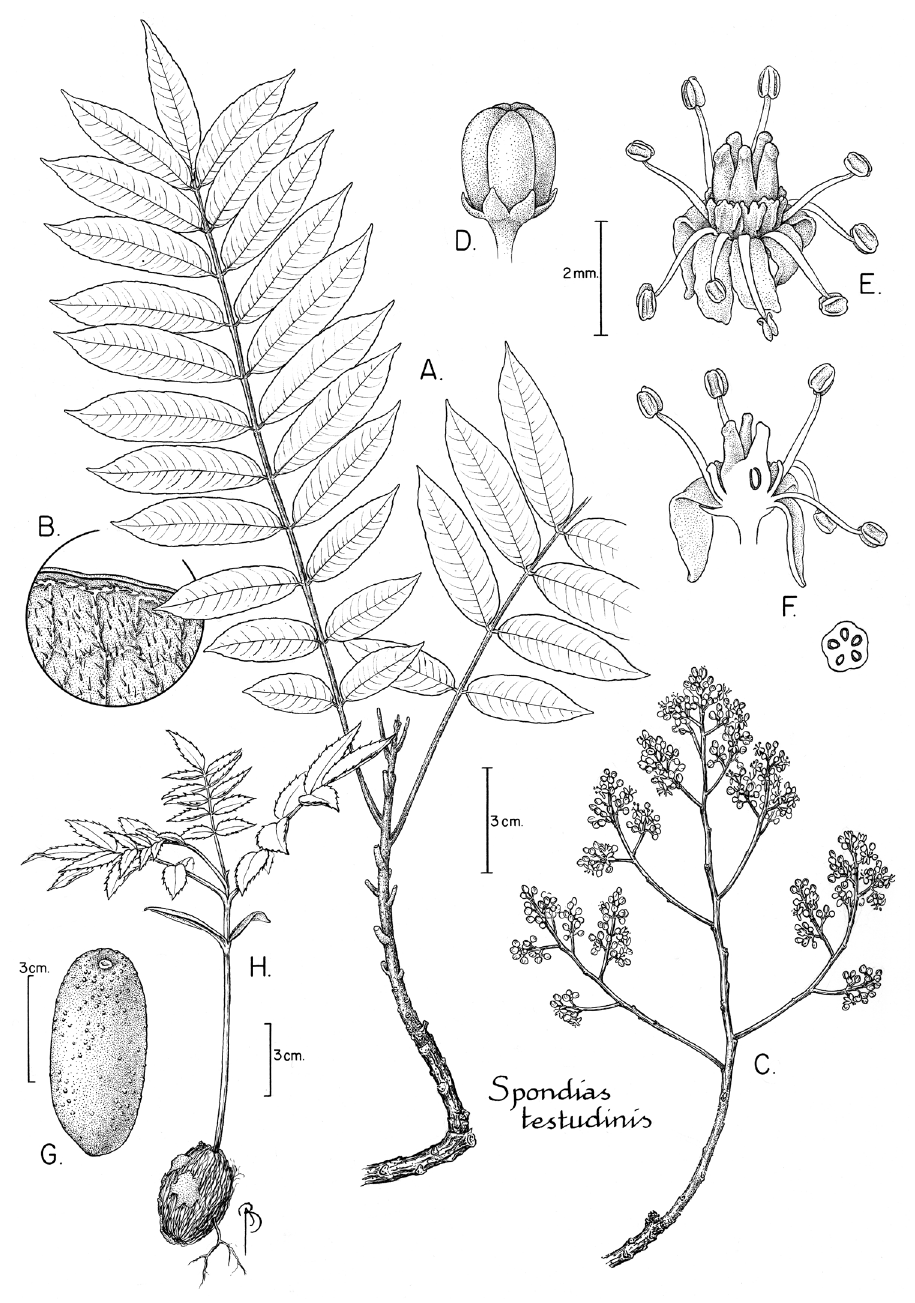
Figure 17. Spondias testudinis . A Branchlet B Detail of leaflet blade and margin C Inflorescence D Bud E Flower at anthesis F Longisection through same at center G Fresh fruit H Seedling. A, B from Lao Magín 112 (NY) C–F from Lao Magín 83 (NY) G from specimen and field photo of Daly et al. 7559 (NY) H from specimen and field photo of Daly et al. 7251